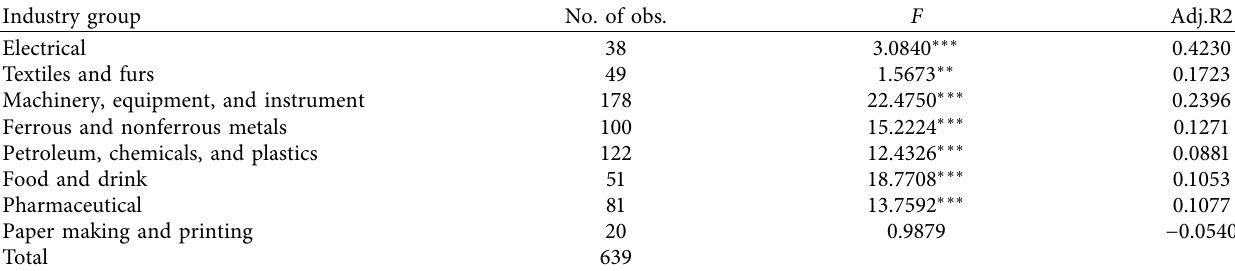
Table 1: Description of industry group sample used to estimated current accruals.